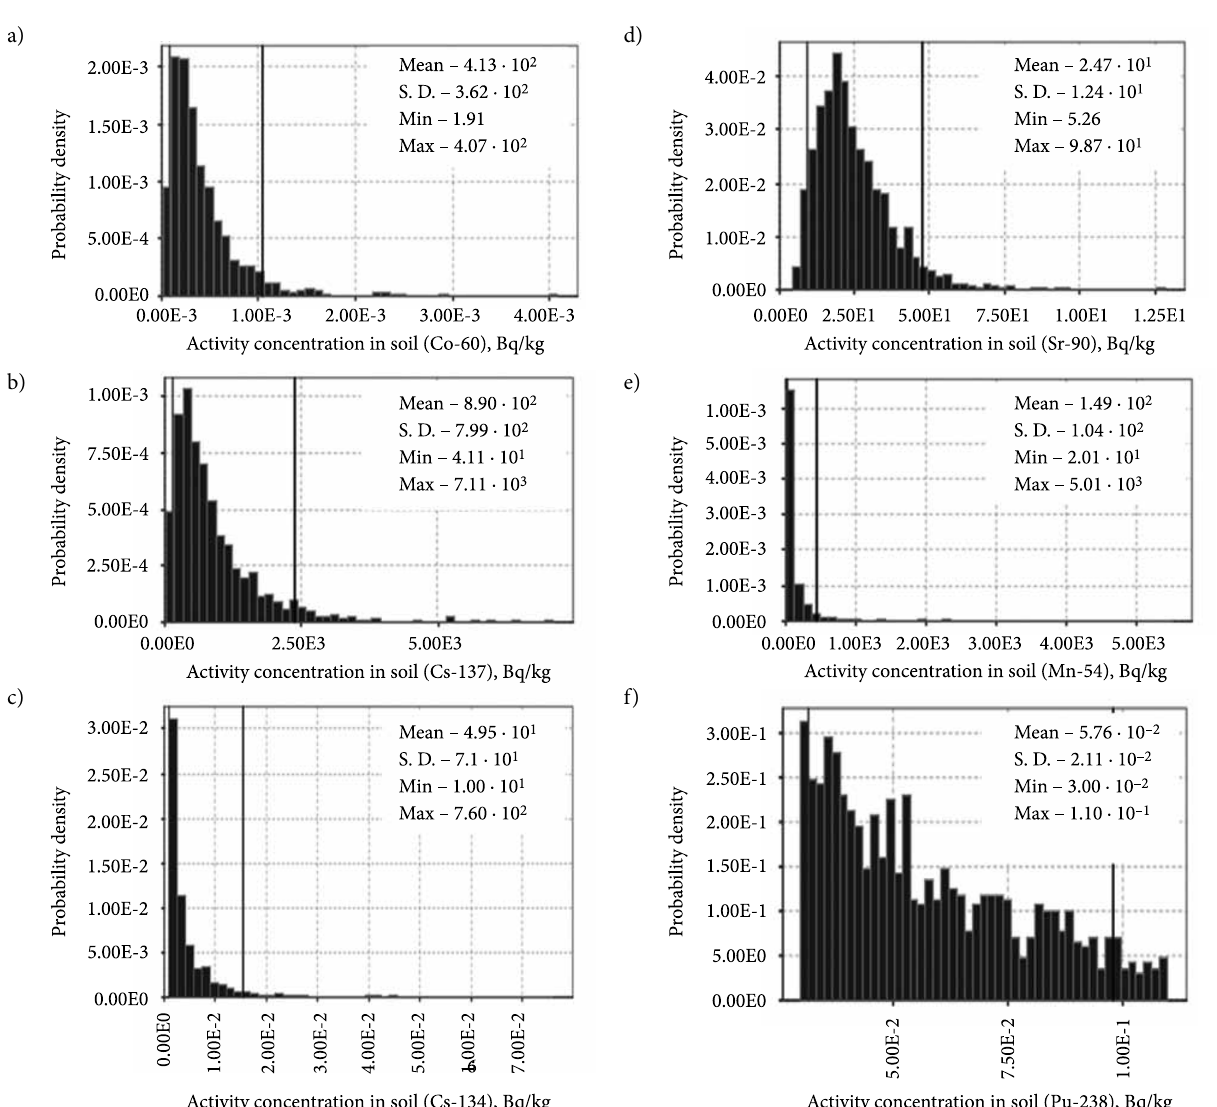
Fig. 6. The frequency histograms of anthropogenic radionuclide activity concentration in soils of INPP